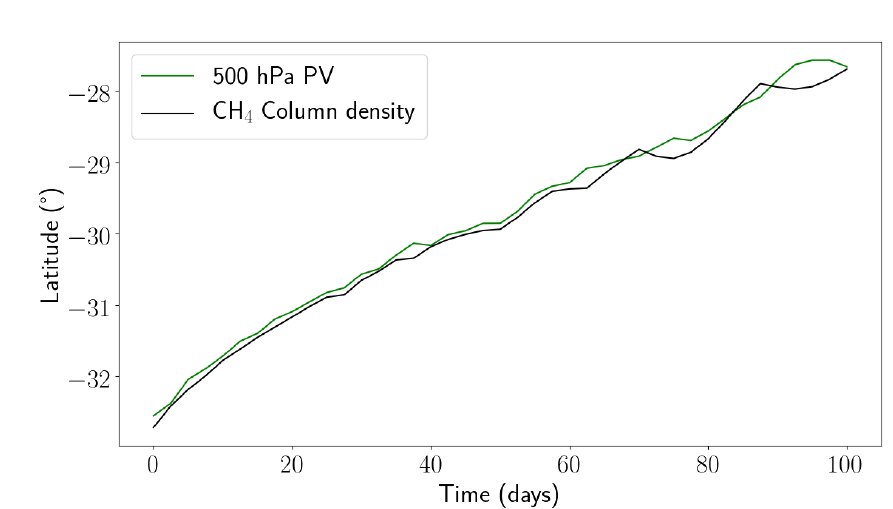
Figure 7. Drift of dark spot from Simulation 21 based on elliptical fit of closed potential vorticity contour and methane optical